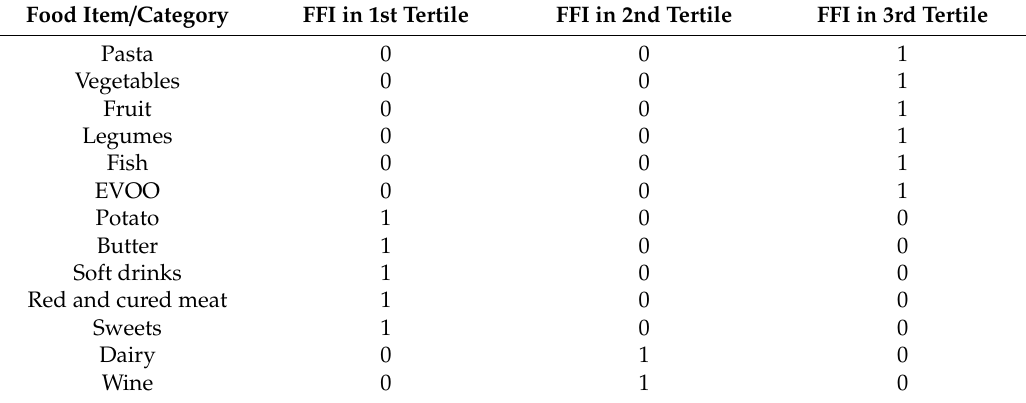
Table 1. Attribution of adherence scores based on the tertile distribution of the individual Food Familiarity Index (FFI). (EVOO = extra virgin olive